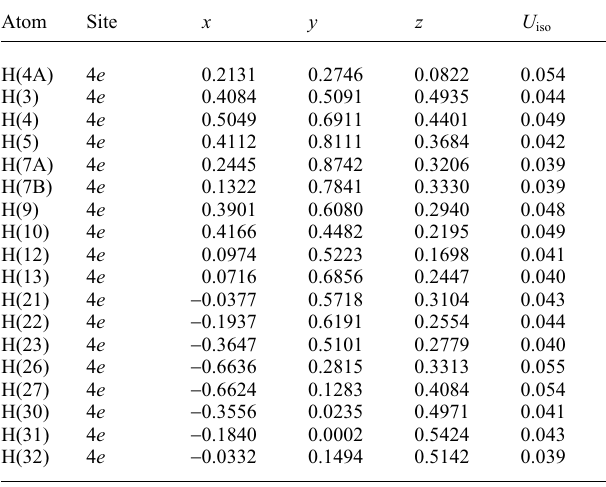
Table 2. Atomic coordinates and displacement parameters (in Å 2 )